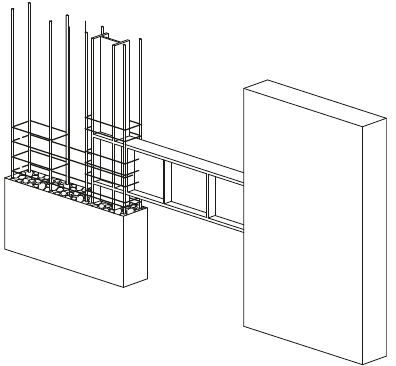
Figure 1: Sketch of the HCW system with connection